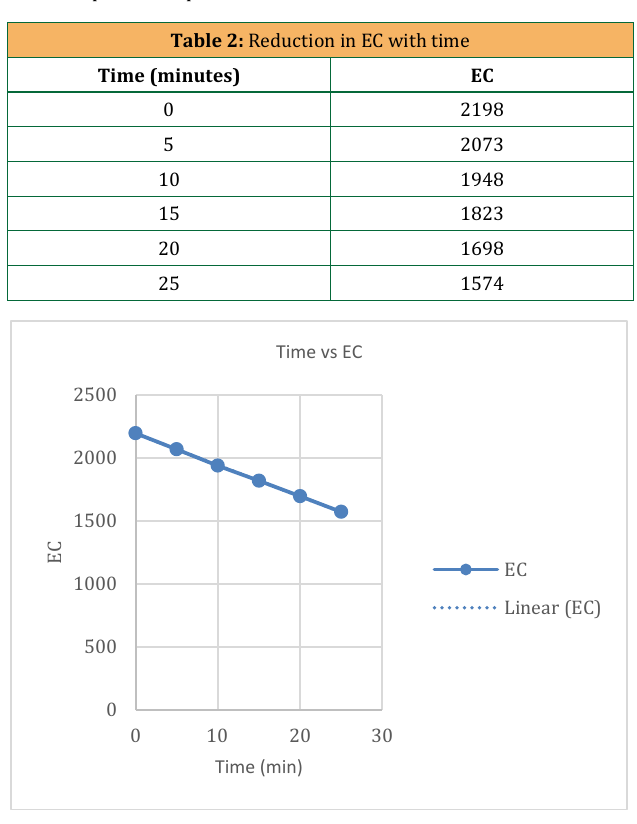
Figure 3: Graph between time and